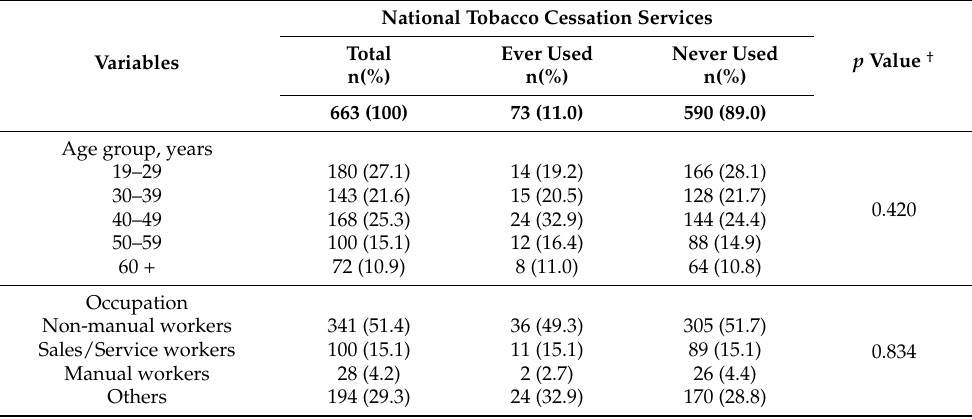
Table 1. Demographic and smoking-related characteristics of the survey participants ( n =